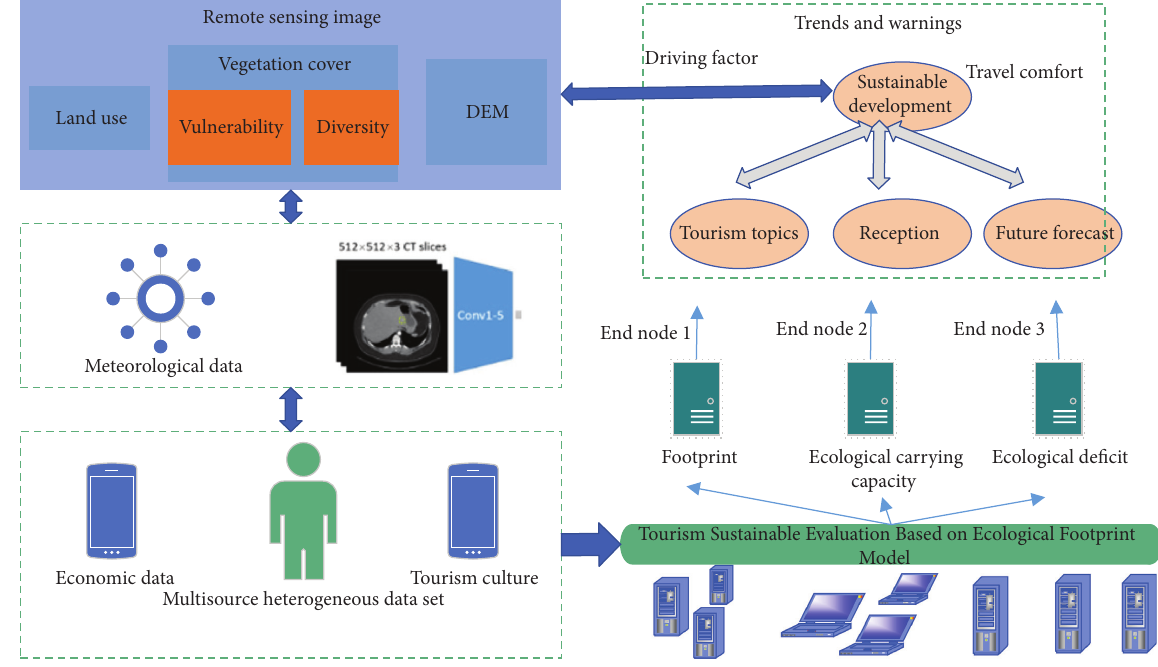
Figure 1: Frame diagram of big data analysis of tourism information Table 1: Biodiversity weight table.